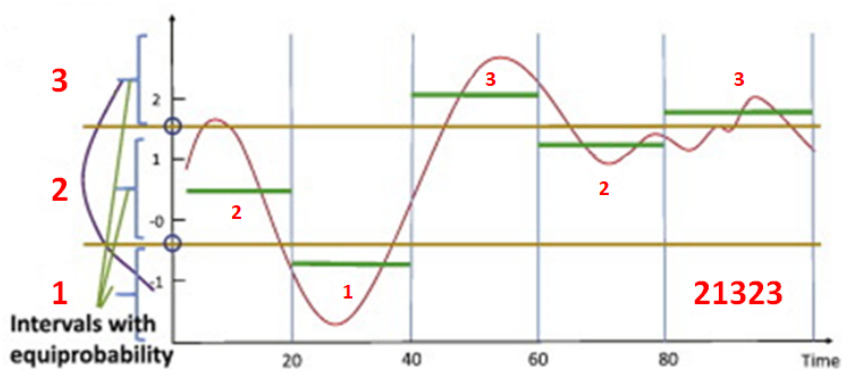
Figure 3. Translation of a sample raw series into a symbolic string using Symbolic Aggregate Approximation ( SAX ), adapted from [29]. Breakpoints for symbol designation are shown as brown horizontal lines. Green lines indicate average series values within a series segment (split by black vertical